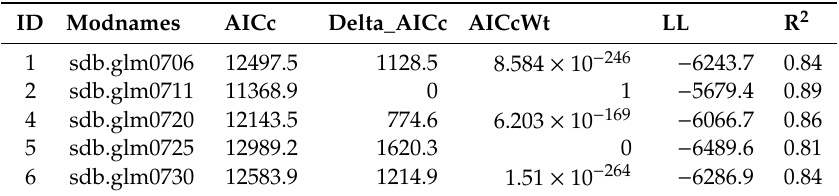
Table 2. Comparison of AICc values calculated by the multiple linear regressions for the SDB estimation of the in-situ data (training) and the log-transformed spectral bands (Blue-Green-Red) of the PlanetScope